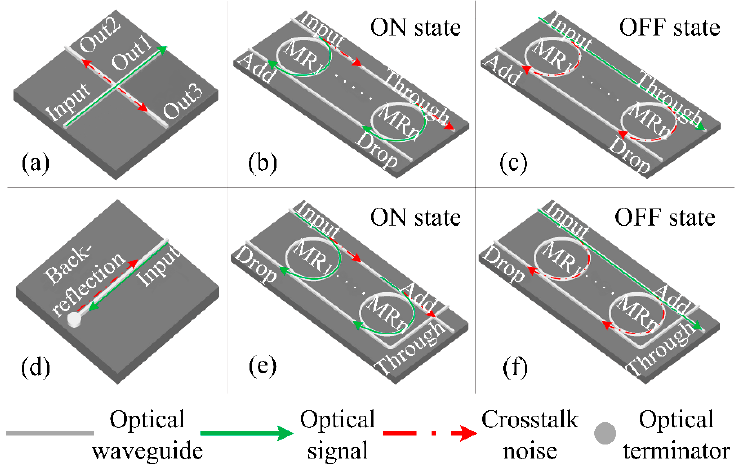
Figure 1. ( a ) Waveguide crossing; ( b ) wavelength division multiplexing (WDM)-based optical parallel switching elements (WPSE) at ON state; ( c ) WPSE at OFF state; ( d ) optical terminator; ( e ) WDM-based optical crossing switching elements (WCSE) at ON state; ( f ) WCSE at OFF state.